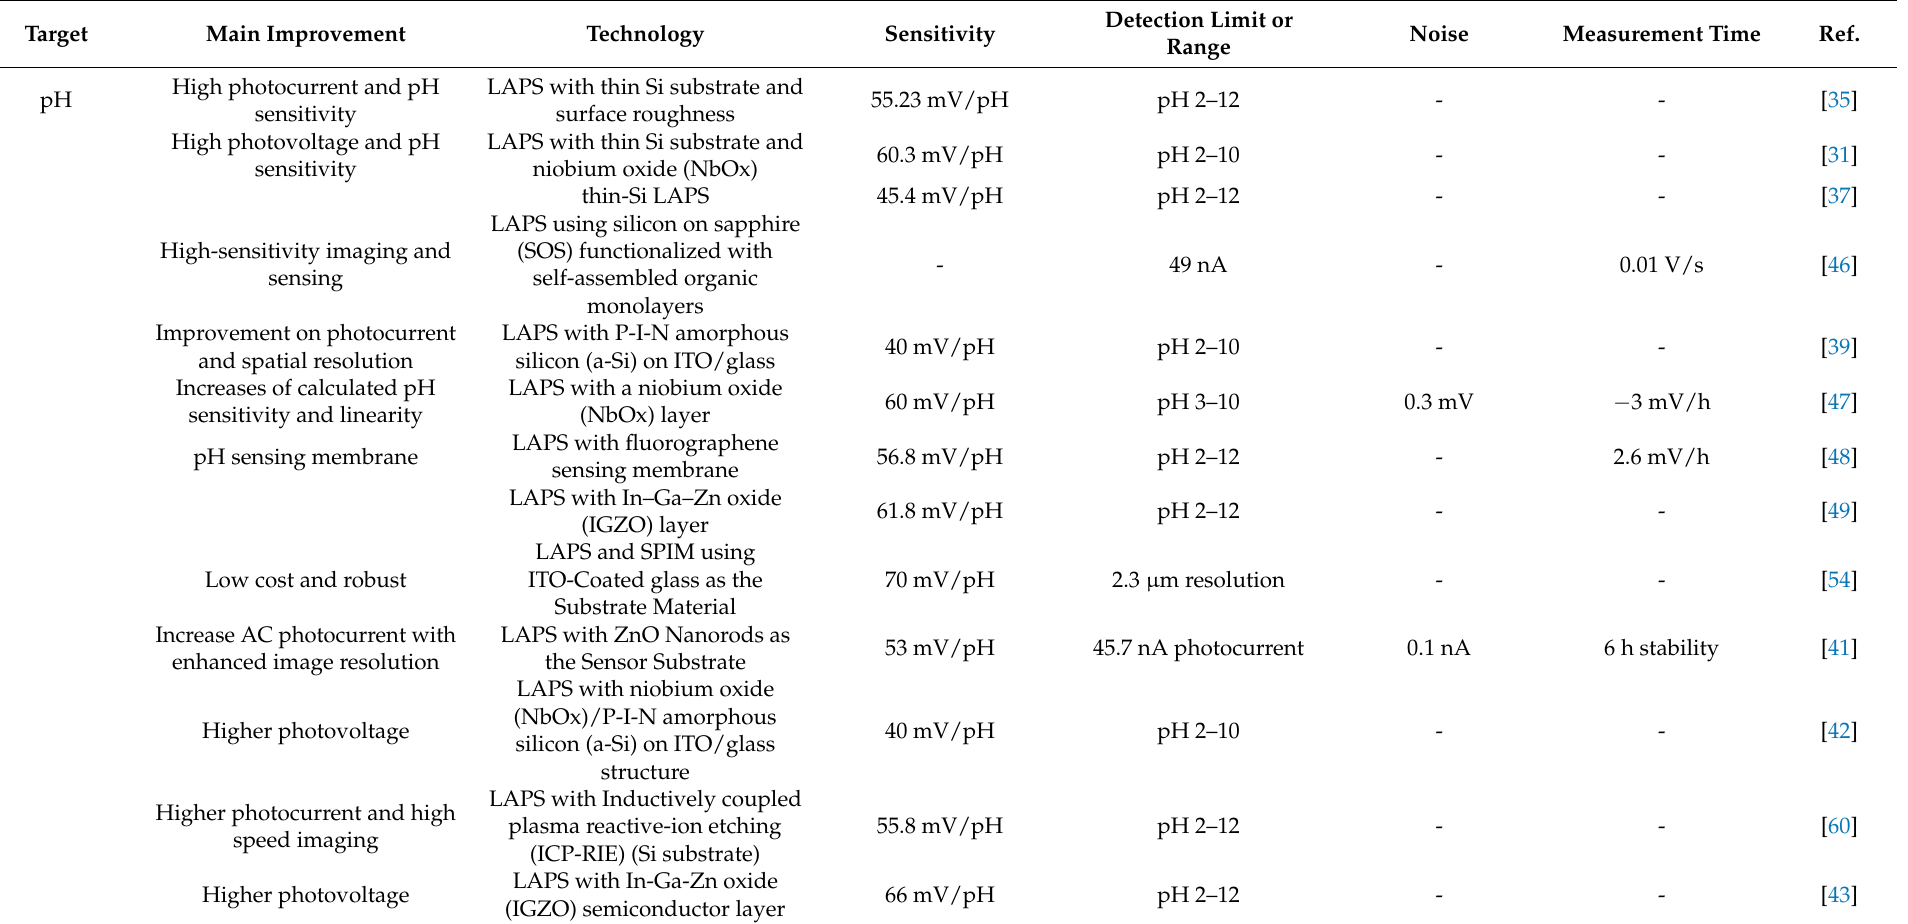
Table 2. Targets, main improvements, technology, detection limits or ranges, noise and measurement times of articles on the improvements in LAPS chip materials published in recent